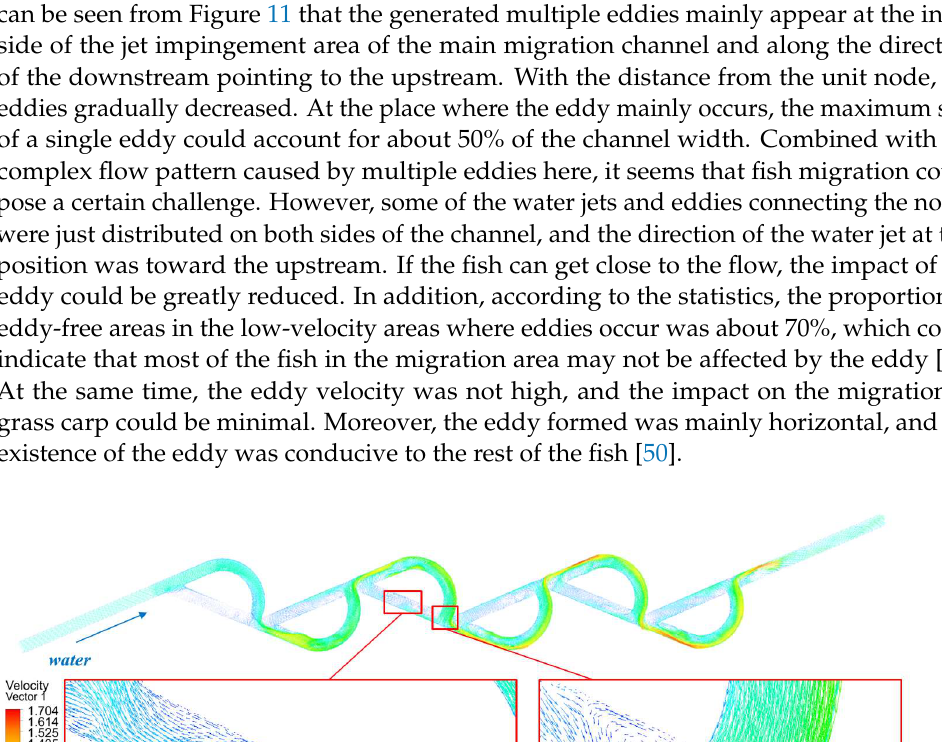
cording to the ideal migration route, the fish in this area passed through a short time or did not pass through, so it was more friendly for fish migration.